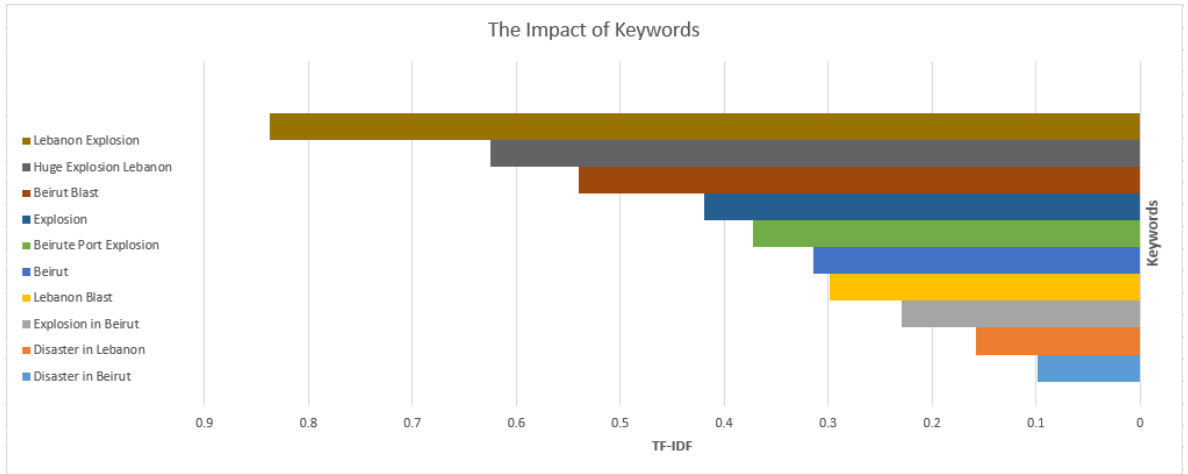
Figure 10. The impacts of the selected